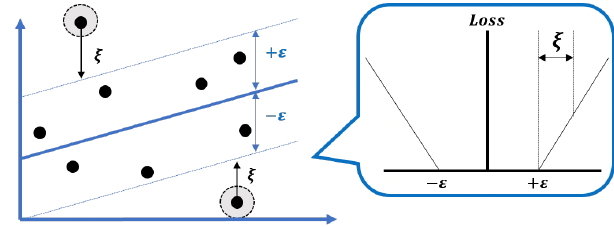
Figure 4. ε -insensitive loss